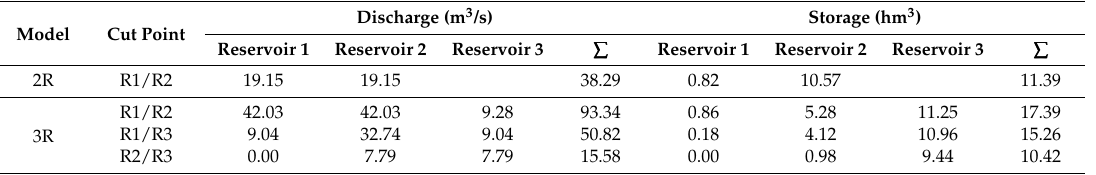
Table 8. Discharge and storage for each reservoir in the cut